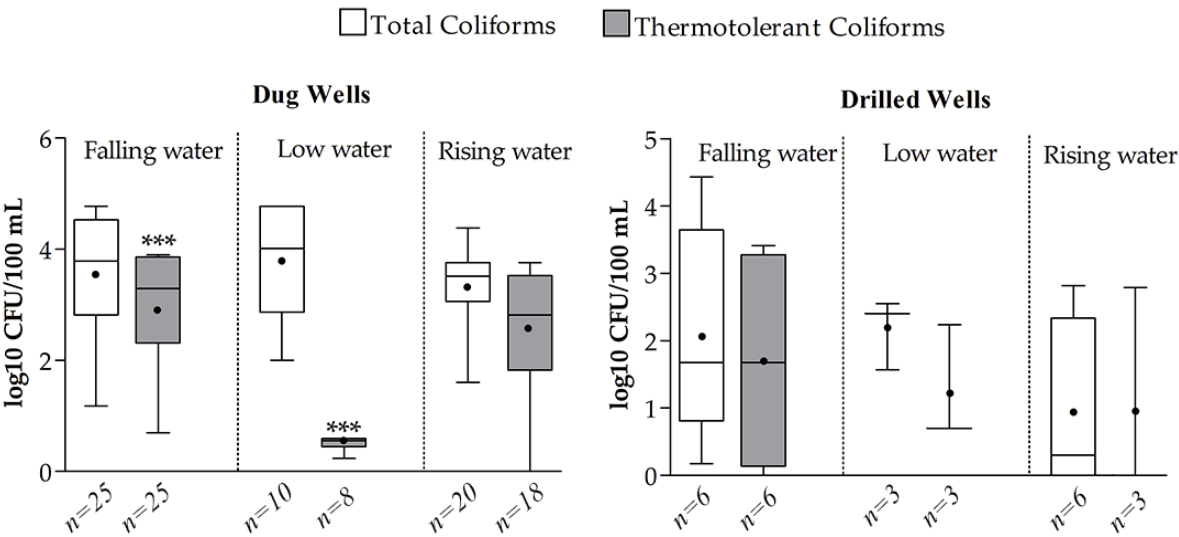
Figure 3. Box plot (min/max, lower/upper quartile, median, average) of the values of total and thermotolerant coliforms at the points sampled during different seasonal periods and from dug and drilled wells. Groups with significant differences are indicated by asterisks (***). P-values were 0.001 for dug wells and 0.5325 for drilled wells.